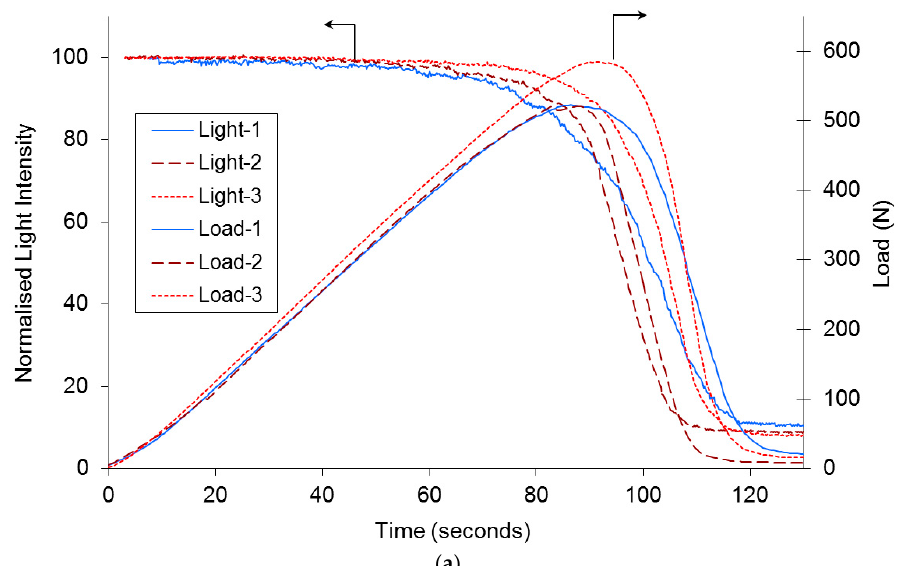
Figure 6 . Cont . Figure 6.